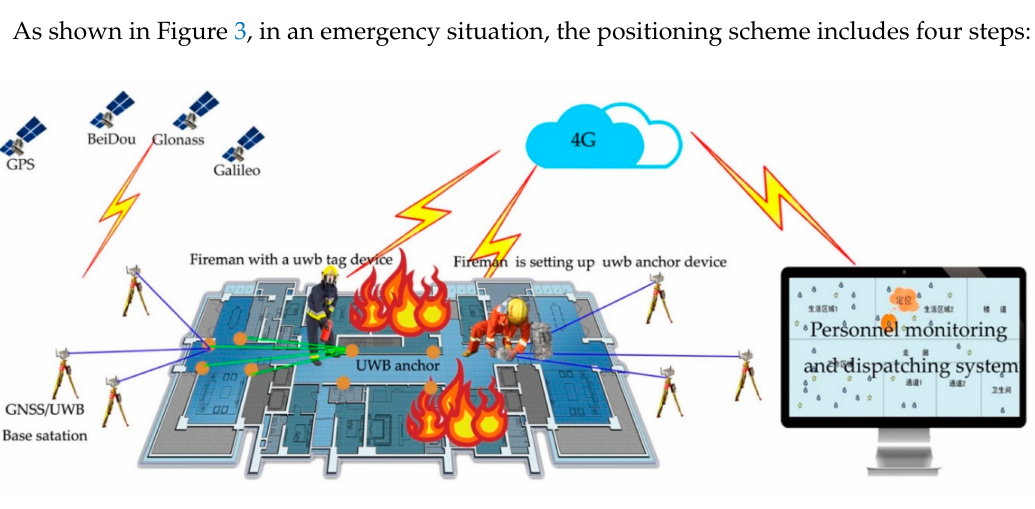
Figure 3. Indoor and outdoor seamless emergency positioning scheme based on GNSS / UWB